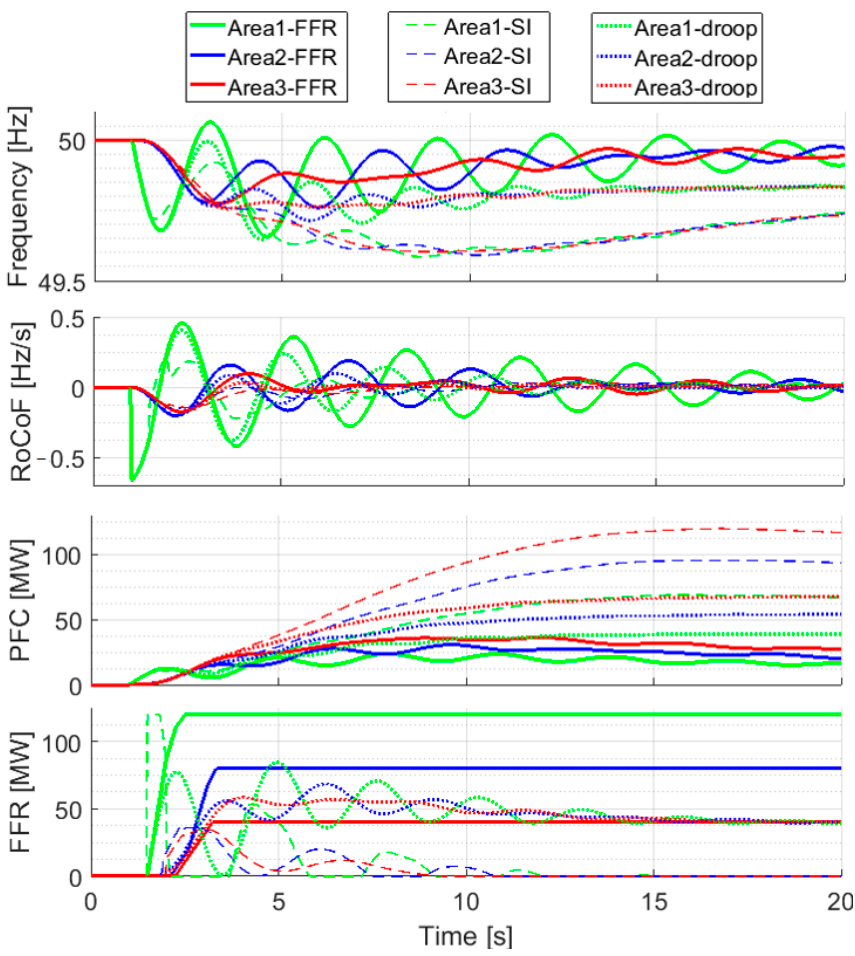
Figure 16. Three-area test system response in the case of a disturbance in a low-inertia area—Case